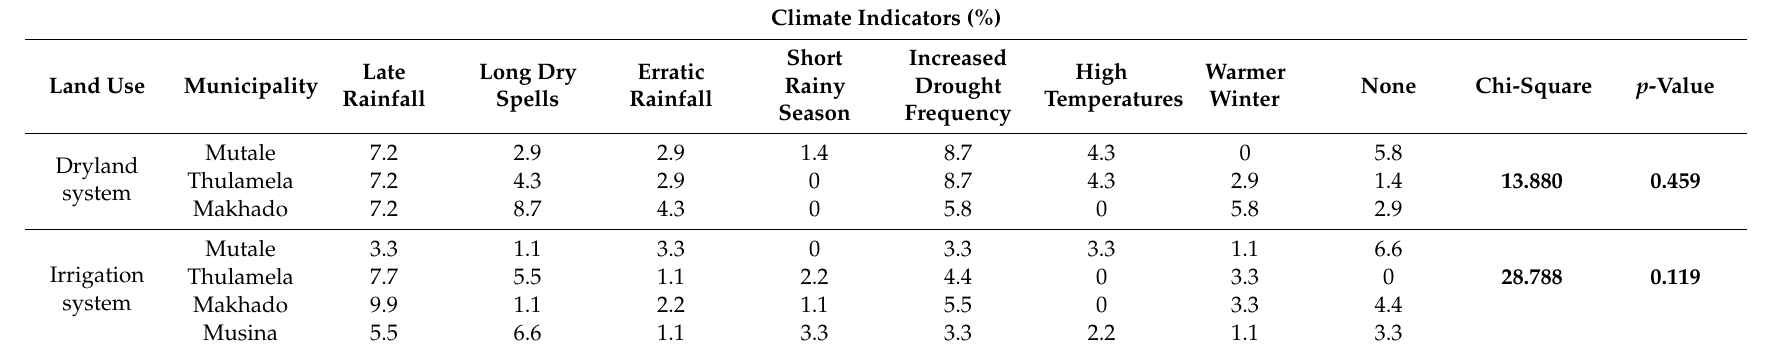
Table 2. Climate indicators perceived by farmers within municipalities in Vhembe